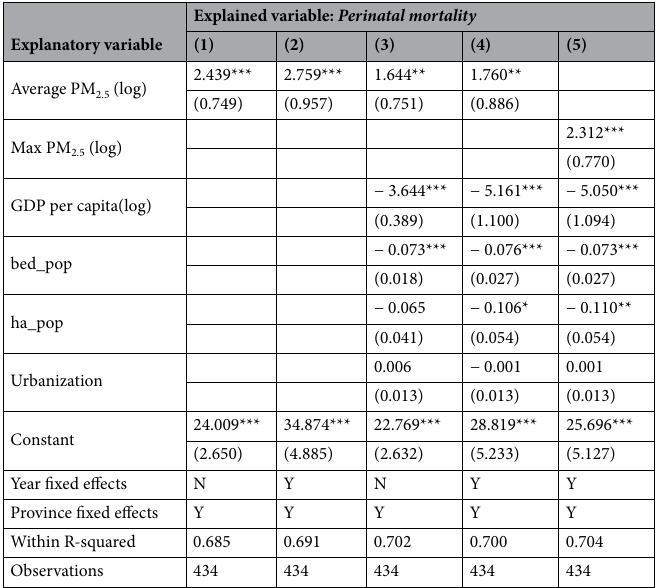
Table 2. The impacts of average PM 2.5 concentrations on perinatal mortality rates. Standard errors in parentheses. * p < 0.1, ** p < 0.05, *** p < 0.01.